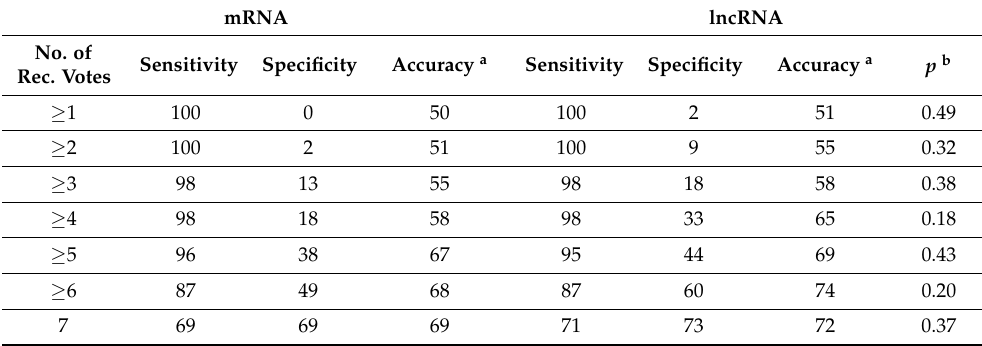
Table A2. Integrated voting results for ER positive BC patients following classification with ≥ 90% sensitivity threshold.